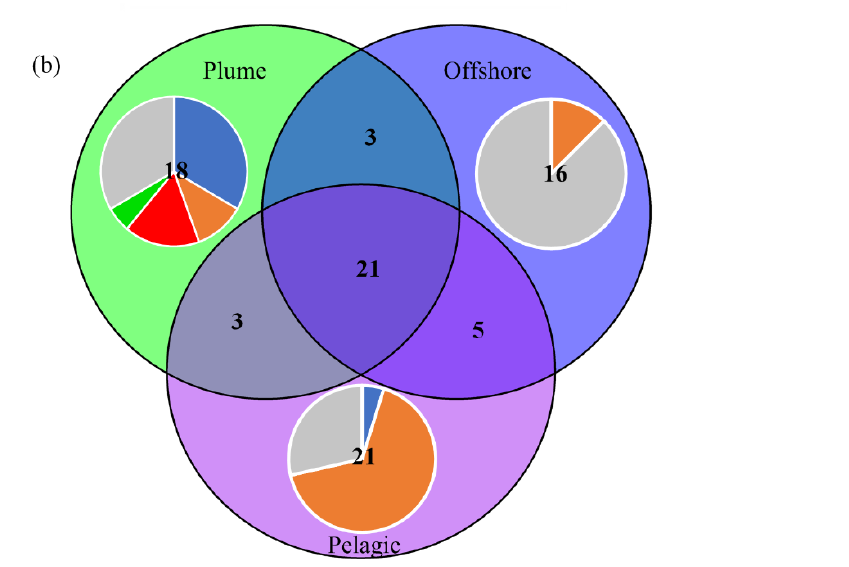
Figure 6. Genus composition of the dominant (Top 50 abundant) LP ASVs along the salinity gradient: ( a ) Average relative abundance of LP genera across different habitats; ( b ) Venn analysis of the dominant ASVs of different habitats. The percentage of the pie chart means the genera composition of the specific dominant ASVs in different habitats.